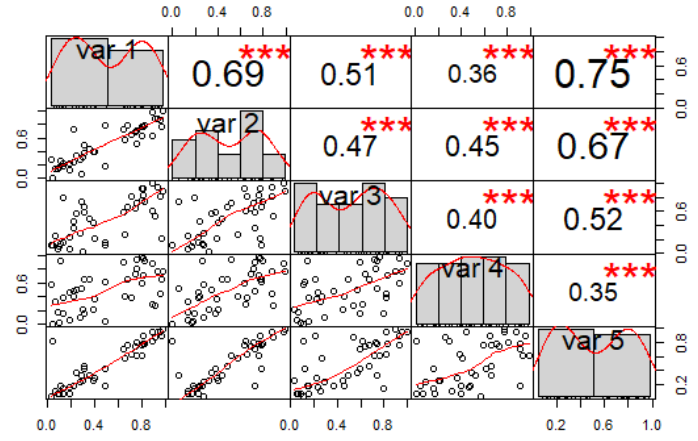
Figure 6. Pair-plots (bottom left of the diagonal), Kendall’s τ values (top right of the diagonal), and the histograms (diagonal) of the volume variable in the five stations.